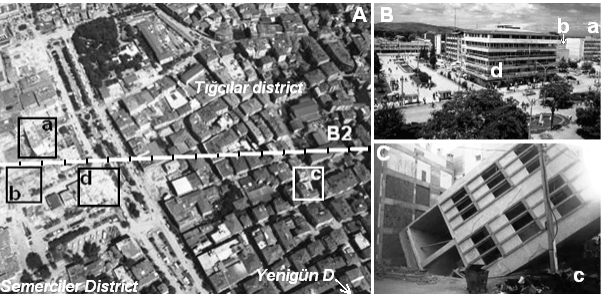
Fig. 4. (A) Aerial view of central Adapazarı and the location of cross section of B2 line. (B) Governor’s office Adapazarı before earthquake (a), military drafting office and court house (b) and ATSO building (d). (C) building toppled as a result of liquefaction in Tigcilar district